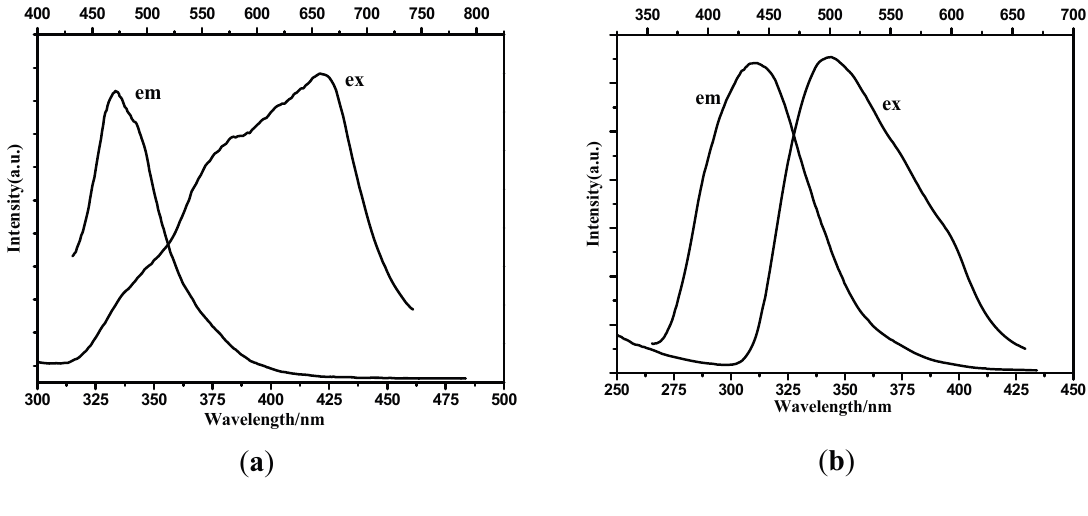
Figure 6. Fluorescence excitation and emission spectra of 1 ( a ) and 2 ( b ) in the solid state at room temperature. ( λ ex = 421 nm, λ em = 471 nm for 1 ; λ ex = 344 nm, λ em = 439 nm for 2 ).